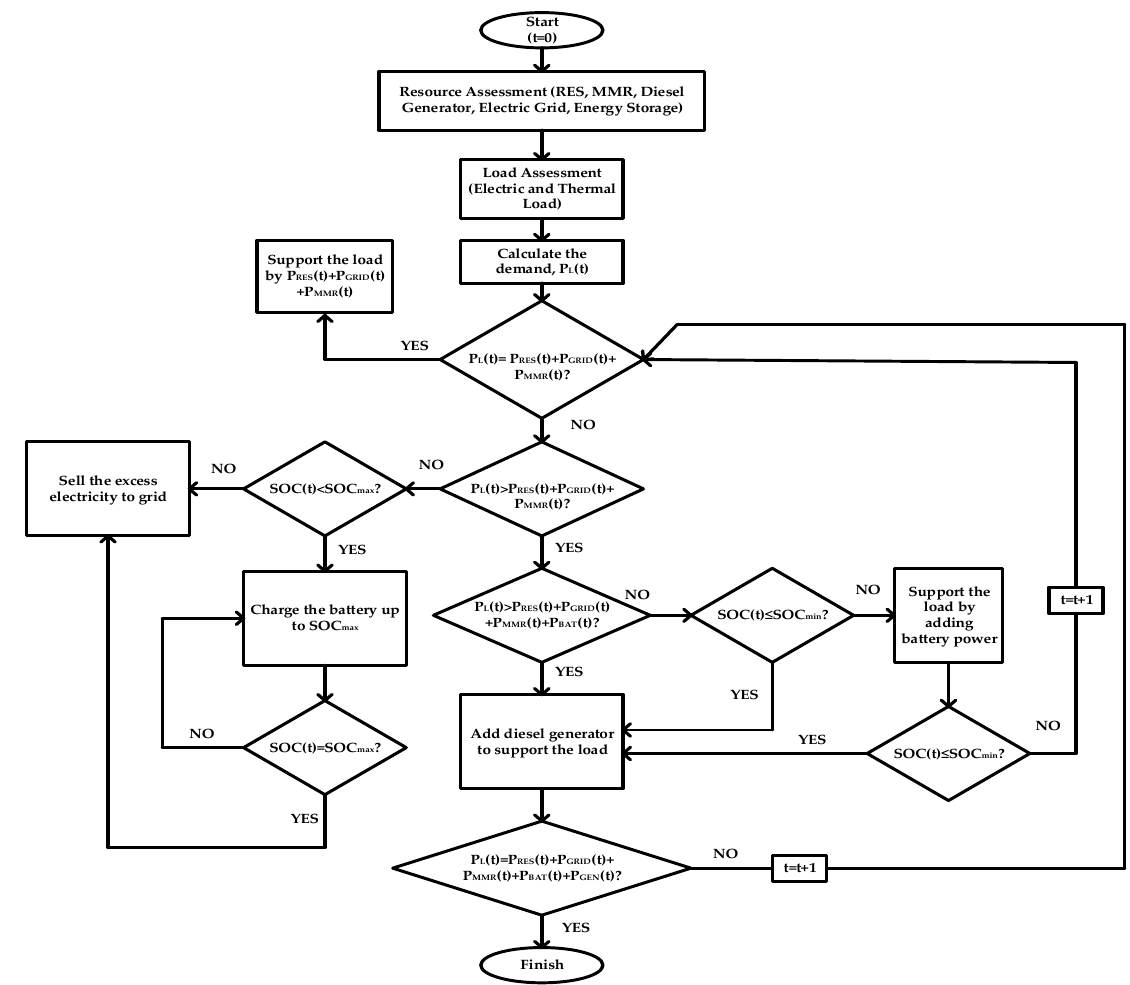
Figure 7. Control algorithm.